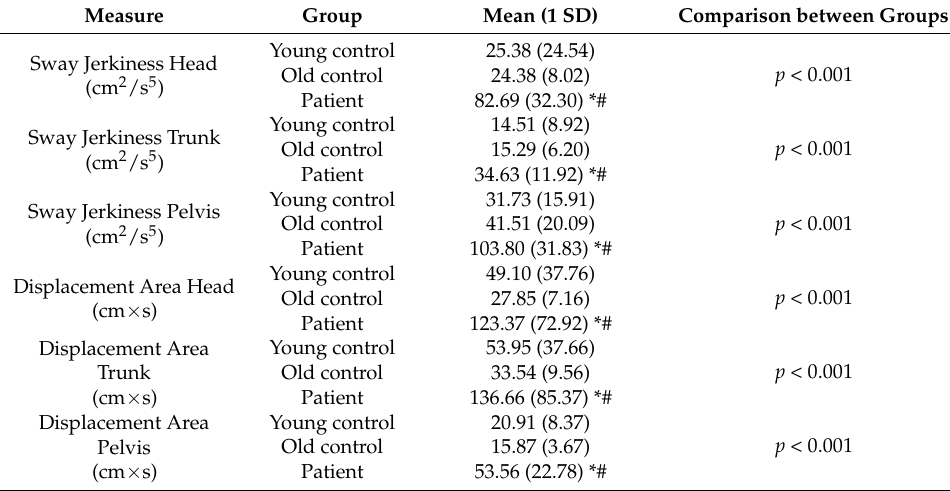
Table 3. Group comparison of postural sway variables with the eyes closed condition.